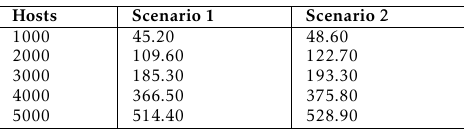
Table 6. Memory Requirements (in MB) Hosts Scenario